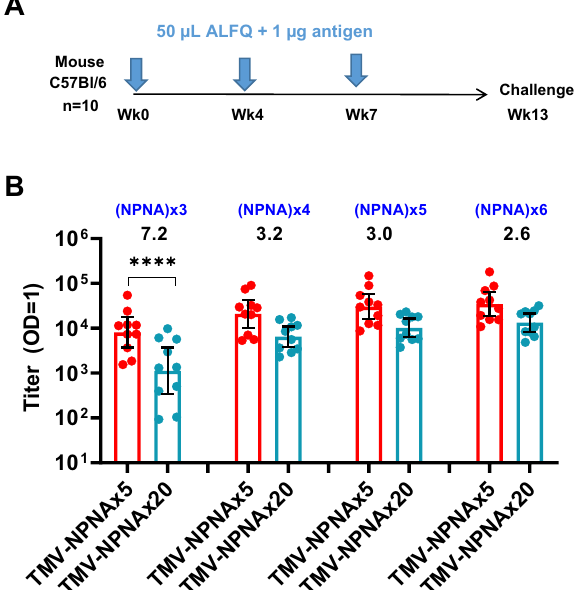
Fig. 6 Study 2 study design comparing TMV-Junc-NPNAx5, TMV- NPNAx5, TMV-NPNAx20, TMV-RI, and repeat valency ELISA. A Outline of mouse study. B Geometric mean titer ± 95% CI for TMV- NPNAx5 and TMV-NPNAx20 sera against biotin-conjugated NPNAx3 to NPNAx6 peptides coated on avidin plates. The fold difference in titer between TMV-NPNAx5 and TMV-NPNAx20 and p values (Mann- Whitney Test, **** [ p < 0.0001]) are